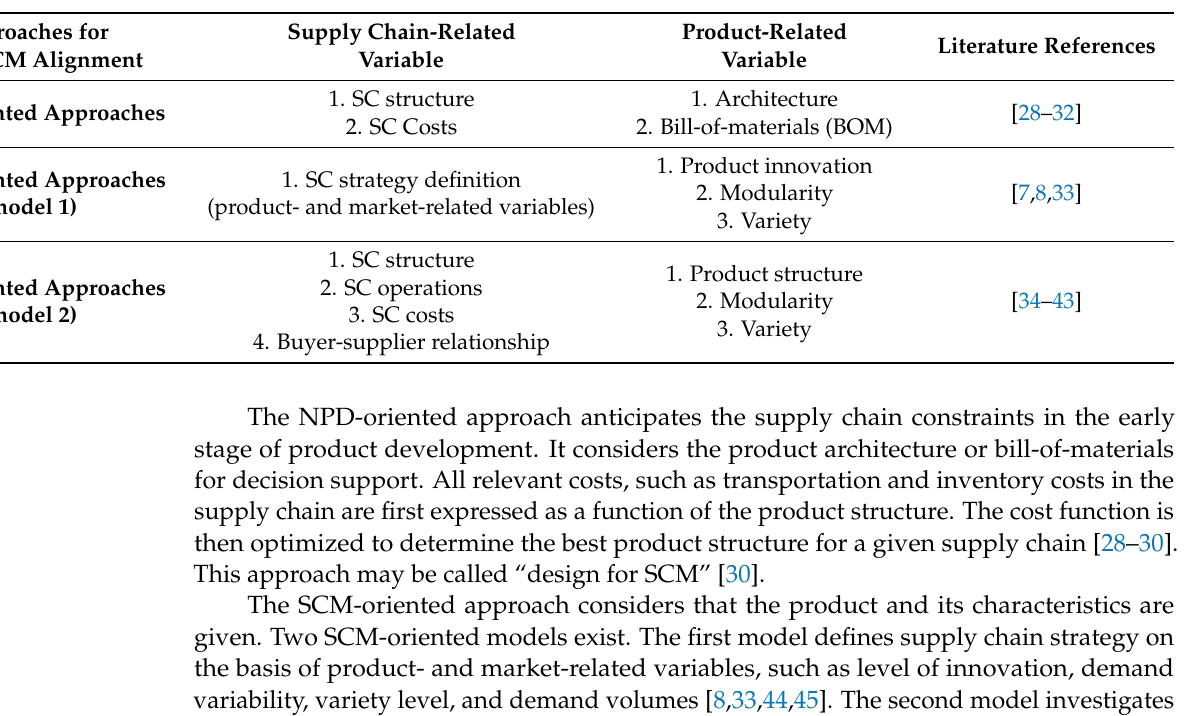
Table 1. Main approaches for the alignment of new product development (NPD) and supply chain management (SCM), adapted from